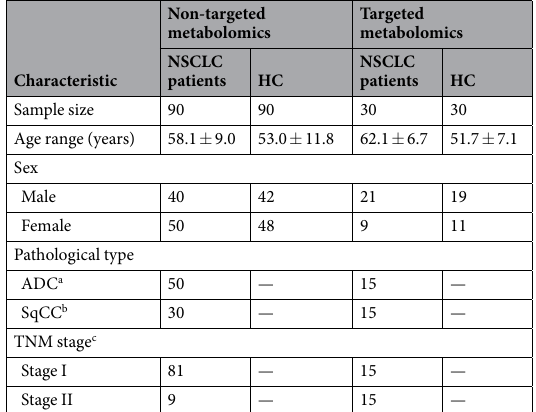
— Table 1. Clinical characteristics of early-stage NSCLC patients, healthy controls (HC) and patients with benign lung disease (LBD) enrolled in this study. a ADC: Adenocarcinoma. b SqCC: Squamous cell carcinoma. c Union for International Cancer Control (UICC) TNM Classification of lung cancer (8th ed.,